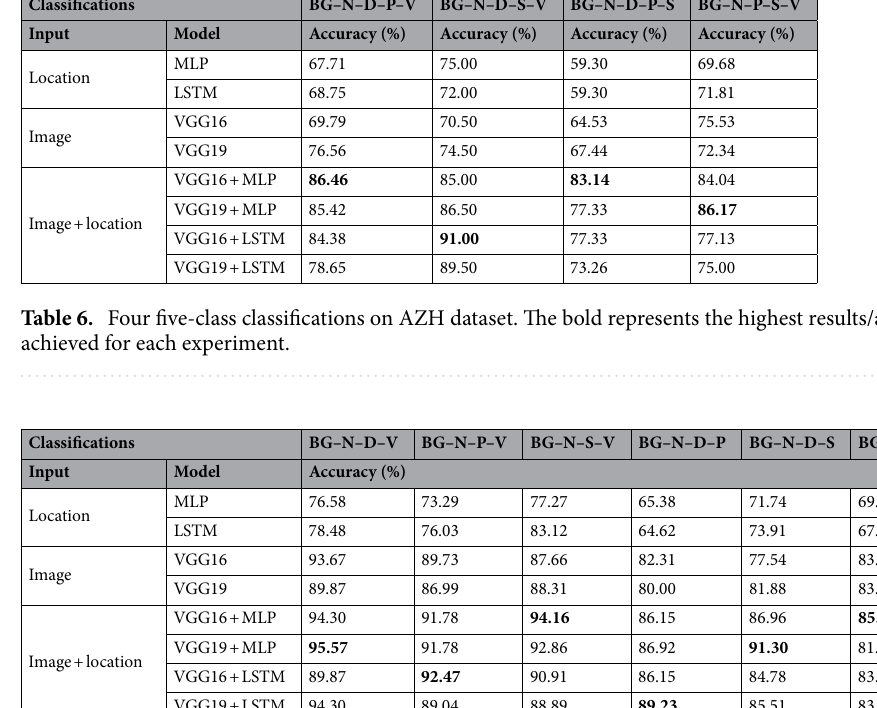
Classifications